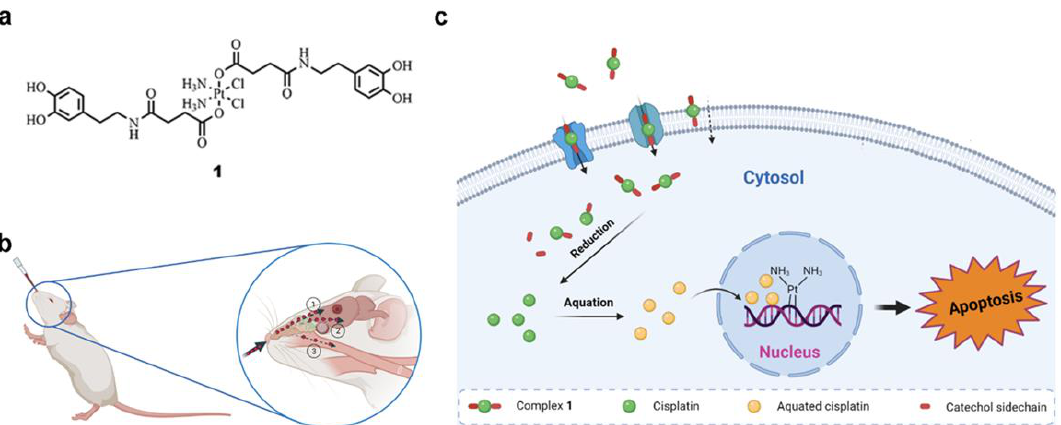
Figure 1. ( a ) Chemical formula of complex 1 . ( b ) IN administration for in vivo tolerability/efficacy evaluation. The substance administered via IN route enters the brain mainly through (1) the olfactory nerve and (2) trigeminal nerve pathways, while a fraction unavoidably would enter the circulation through (3) the airway. ( c ) Possible uptake (mediated by membrane transporters or passive diffusion) and most feasible action mechanism of complex 1 . The Pt(IV) prodrug enters the cell, then becomes reduced intracellularly, and the activated form binds to DNA to induce cell death.